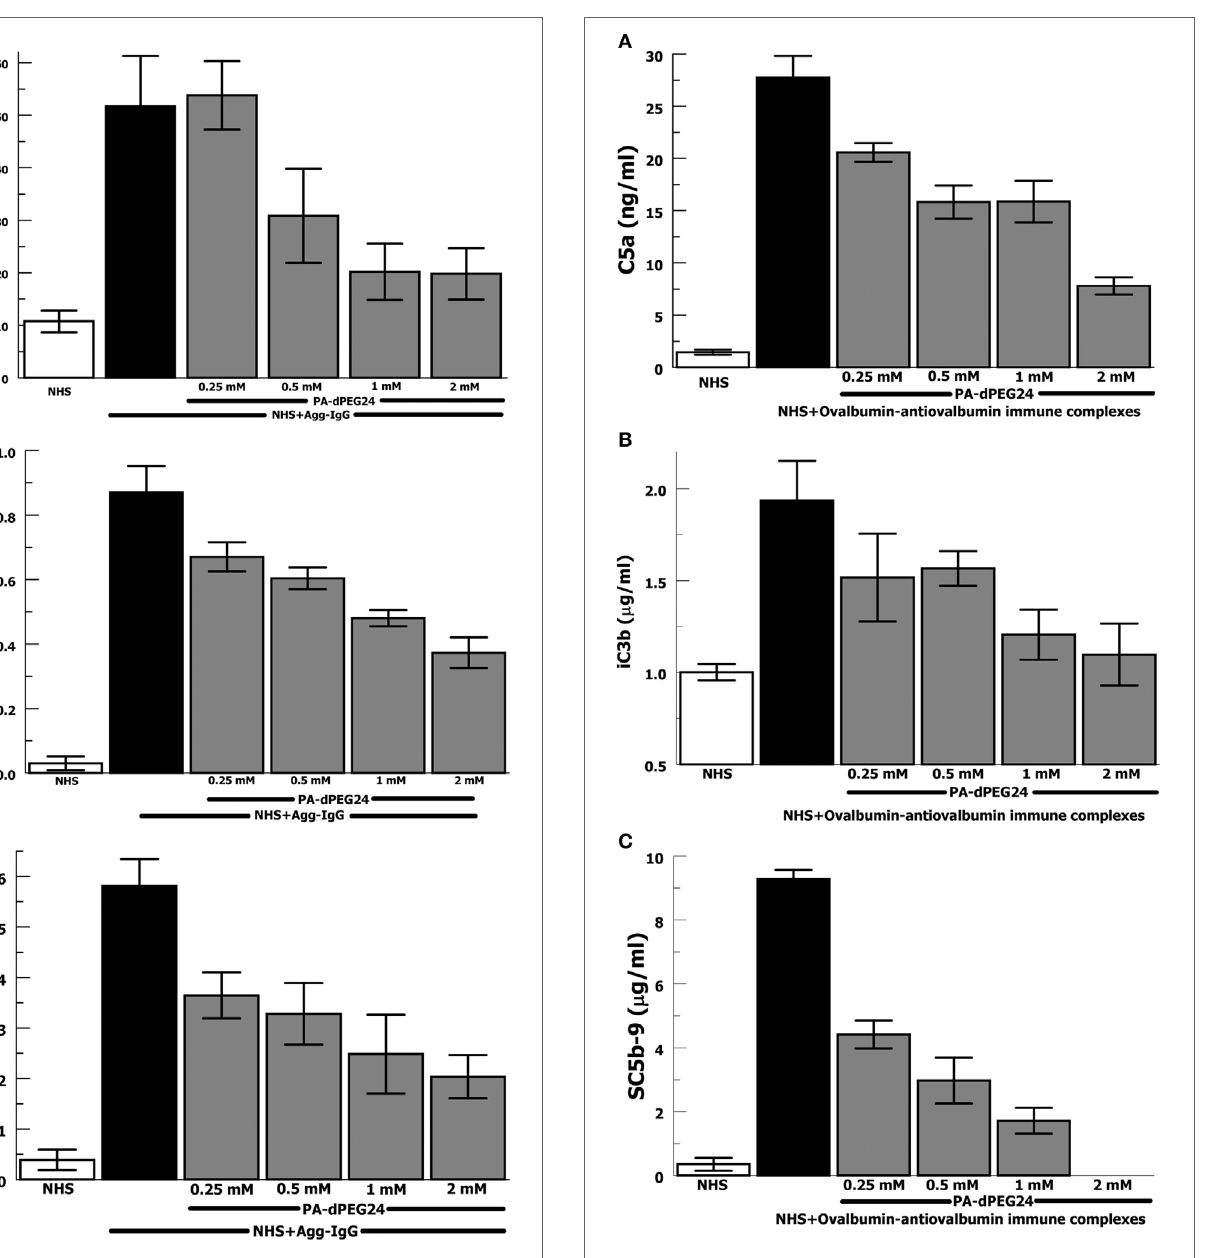
FigUre 1 | PA-dPEG24 inhibition of heat-aggregated IgG (Agg-IgG) immune complex-initated complement activation assayed by complement effectors. (a) PA-dPEG24 inhibition of C5a generation in normal human sera (NHS) stimulated with heat-Agg-IgG immune complexes (IC). Data are means of ( n = 5) independent experiments ± SEM. (B) PA-dPEG24 inhibition of iC3b generation in NHS stimulated with heat-Agg-IgG IC. Data are means of ( n = 4) independent experiments ± SEM. (c) PA-dPEG24 inhibition of SC5b-9 generation in NHS stimulated with heat-Agg-IgG IC. Data are means of ( n = 6) independent experiments ± SEM.